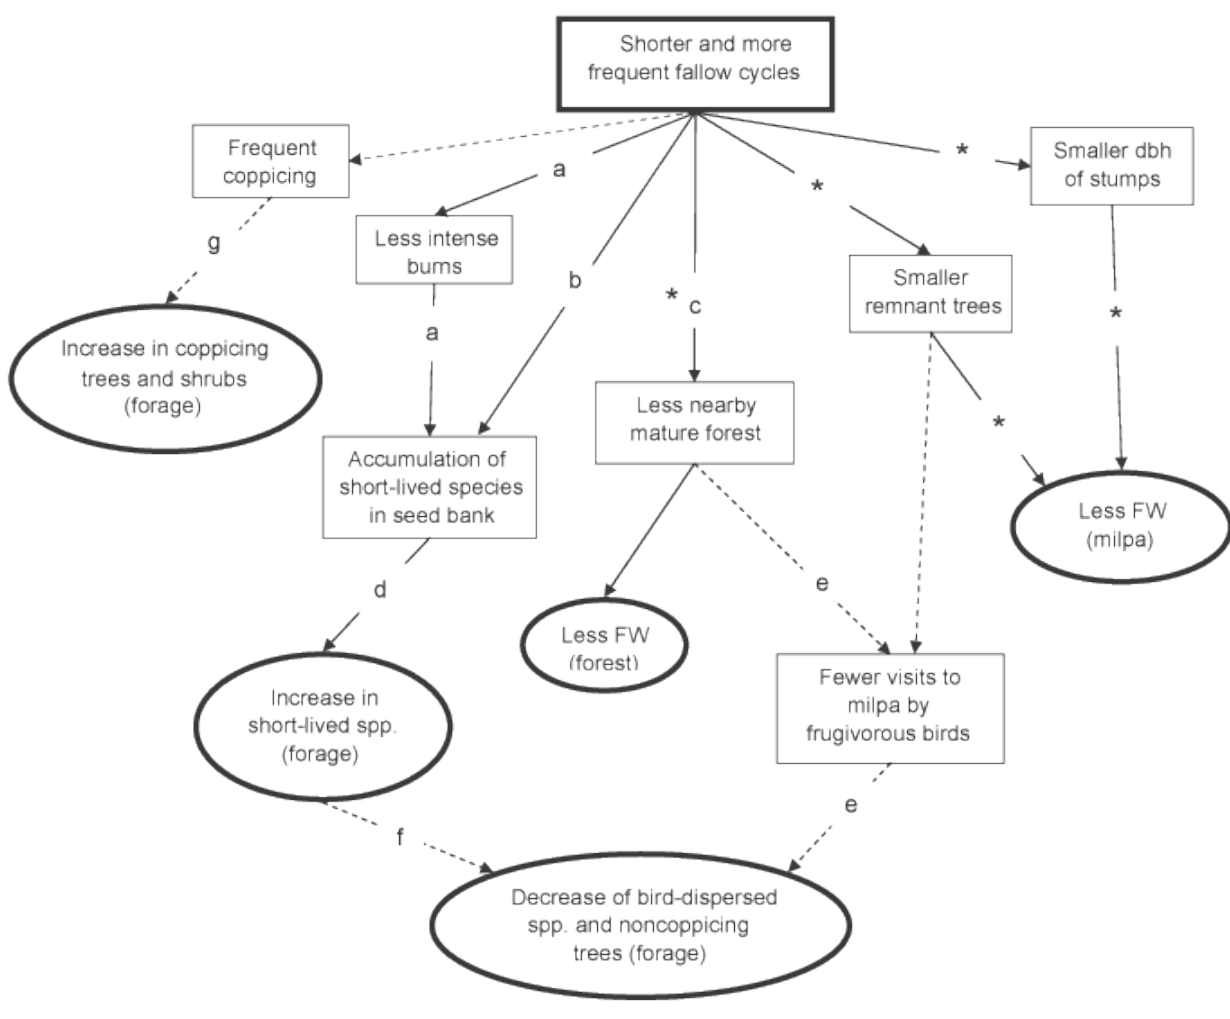
Fig. 8. Proposed relationships between changes in fallow cycles and the availability of forage and firewood (FW) resources. Solid lines indicate relationships that are demonstrated by our data, indicated by an asterisk, or supported by other studies. References are indicated by letters. Dotted arrows indicate hypothesized relationships requiring further examination. Supporting literature: (a) Saxena and Ramakrishnan 1984; (b) Young et al. 1987, Staver 1991, Rico-Gray and Garcia-Franco 1992, Quintana- Ascencio et al. 1996; (c) Mertzger 2003, Lawrence 2004; (d) Saxena and Ramakrishnan 1984, Staver 1991, de Rouw 1995; (e) Suggested by Lawrence 2004; (f) Competitive exclusion by aggressive short- fallow species, suggested by Purata 1986; (g) Suggested by Lawrence 2004, Lawrence et al. 2005, although no evidence for this relationship found in the present study (see